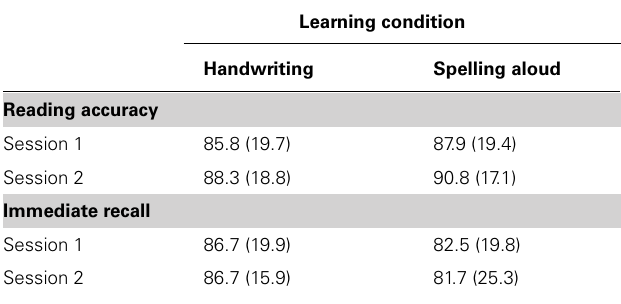
Table 4 | Experiment 2. Mean accuracy (in percentages) and standard deviations for target reading accuracy and for target orthography recall during, the learning phase, according to conditions and